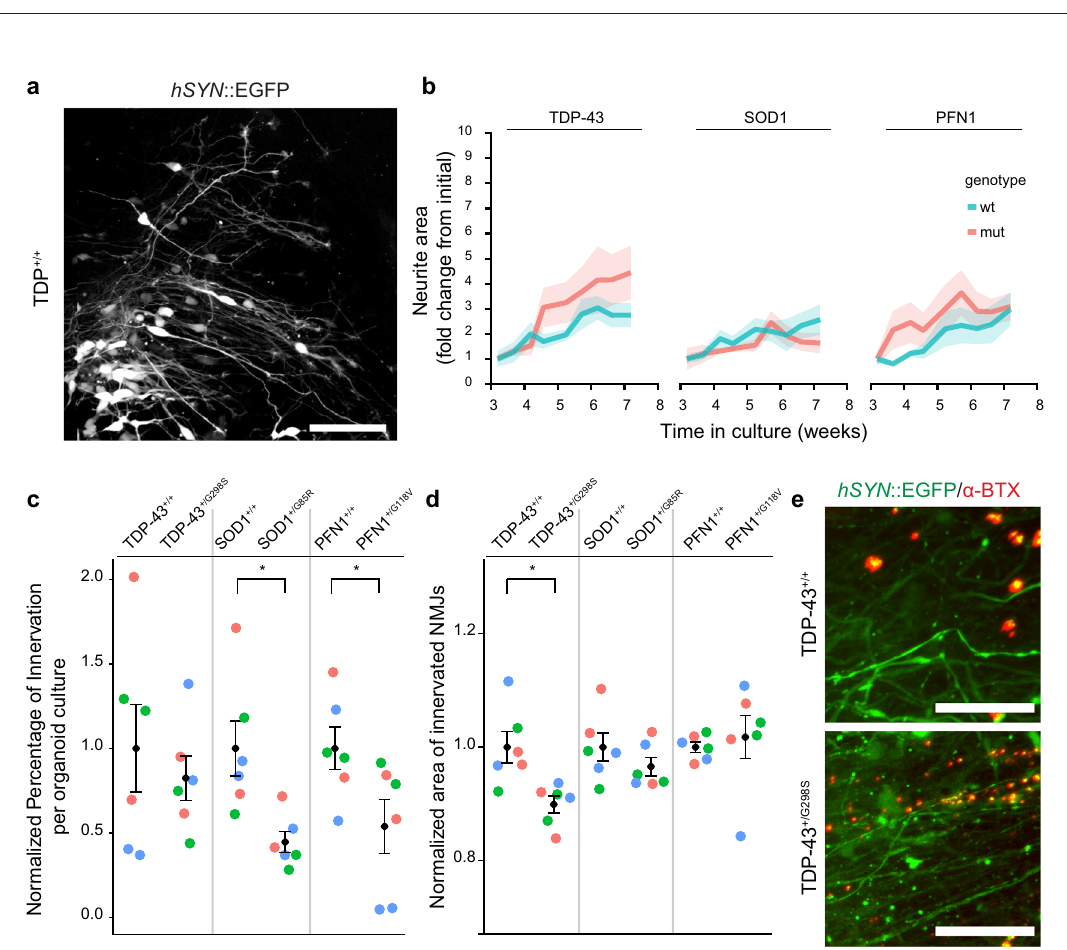
Fig. 7 Isogenic iPSC lines reduce among- and within-line variability of organoid cultures. Analysis of among-line ( a ) – ( e ) and within-line ( f ) – ( j ) variance for individual sphere potency ( a ), ( f ) and area ( b ), ( g ), as well as GFAP + cells ( c ), ( h ), IBA1 + cells ( d ), ( i ), and SAA + area ( e ), ( j ) within mature organoid cultures from two to three independent biological differentiation replicates for each line. a – e l eft , Mean and SEM of fold change from batch average, along with points for individual spheres ( a ), ( b ) or cultures ( c ), ( e ). Right , Mean and SEM among non-isogenic and isogenic lines with points for each unique iPSC line. Signi fi cance assessed by F -test for Equality of Variances, with group variances ( σ 2 ) indicated at bottom, for n = 5 non-isogenic, 6 isogenic lines: ( a ) F = 2.0 × 10 5 , P = 6.8 × 10 − 13 ; ( b ) F = 2.0 × 10 5 , P = 6.8 × 10 − 13 ; ( c ) F = 4.37, P = 0.137; ( d ) F = 106.33, P = 1.0 × 10 − 4 ; ( e ) F = 18.90, P = 0.006. f – j , l eft , Mean and SEM of fold change from batch average within-line, along with points for individual spheres ( f ), ( g ) or cultures ( h ) – ( j ). Right , Mean and SEM of within-line variances for non-isogenic and isogenic lines with points for each unique iPSC line. Signi fi cance assessed by one-way ANOVA for n = 5 non- isogenic, 6 isogenic lines: ( f ) (non-isogenic vs isogenic) 79.9 ± 24.0 vs 7.0 ± 2.1, F = 11.21, P = 0.009; ( g ) 0.052 ± 0.017 vs 0.007 ± 0.002, F = 8.825, P = 0.016; ( h ) 0.603 ± 0.198 vs 0.030 ± 0.004, F = 10.25, P = 0.011; ( i ) 0.711 ± 0.401 vs 0.114 ± 0.035, F = 2.70, P = 0.135; ( j ) 0.328 ± 0.095 vs 0.015 ± 0.003, F = 13.2, P = 0.005. Colors indicate individual iPSC lines.